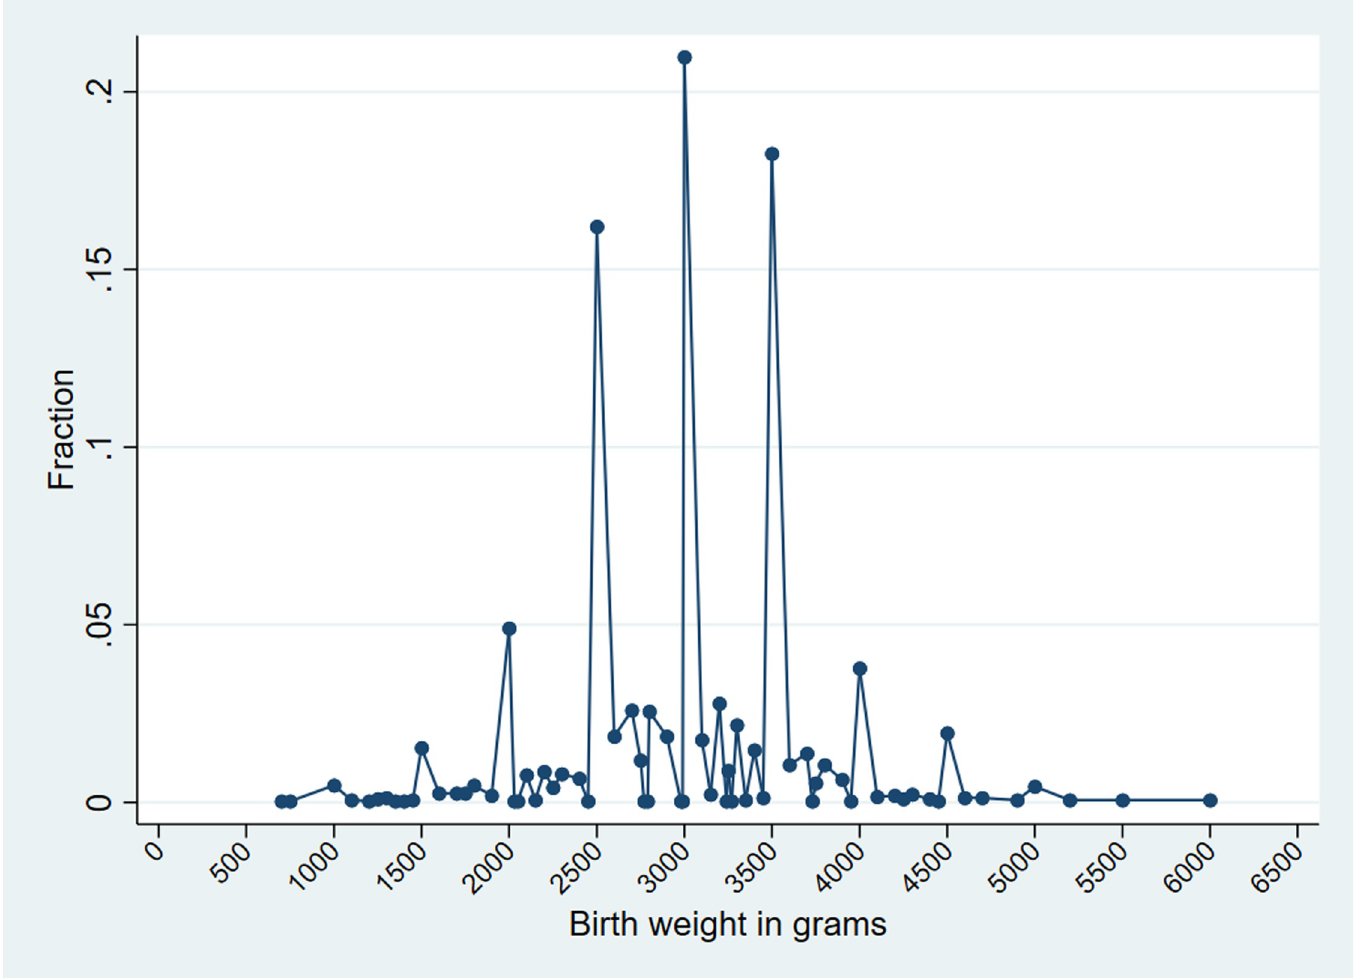
Fig 1. The fraction of newborn children according to their birth weight in grams, NDHS 2016.